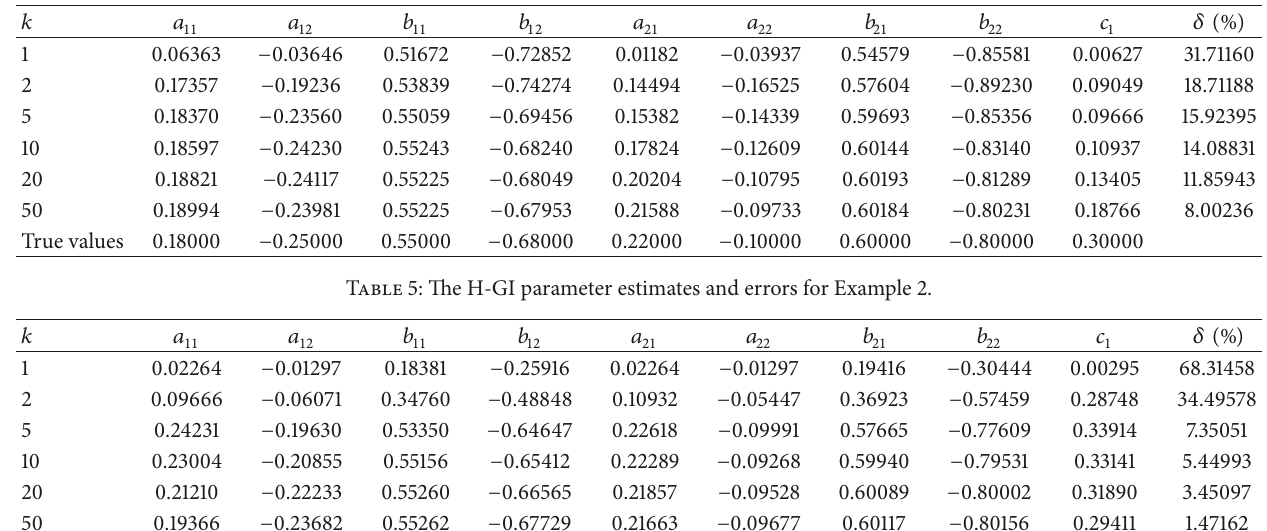
Table 4: The H-GI parameter estimates and errors for Example 2.